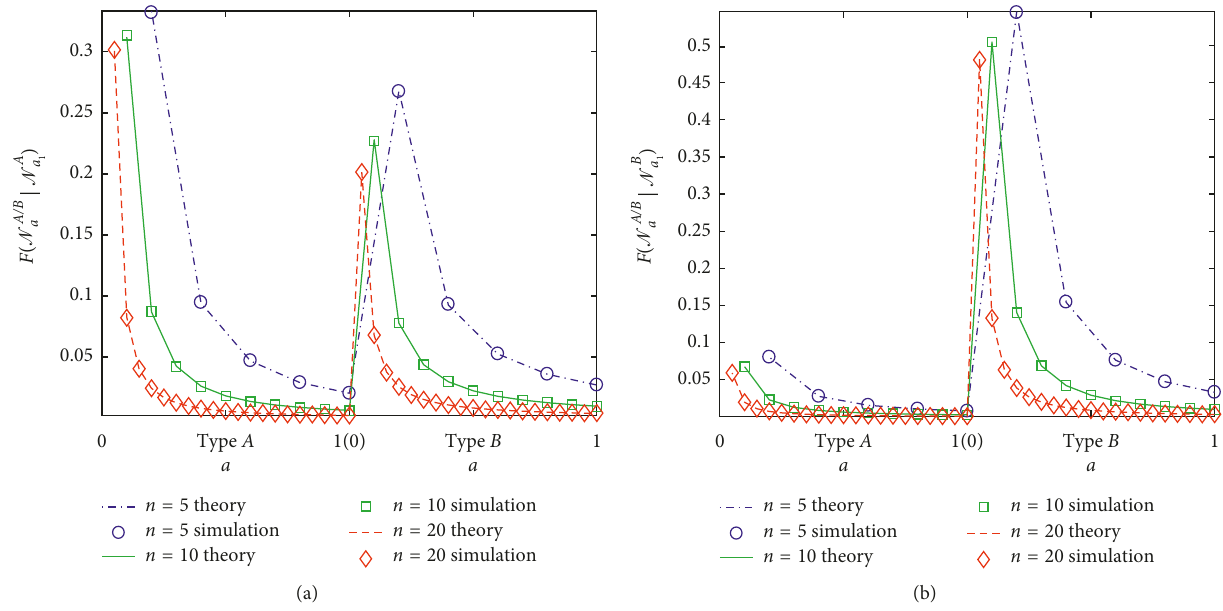
in the instantaneous network G t . In (a) and (b), we show 1